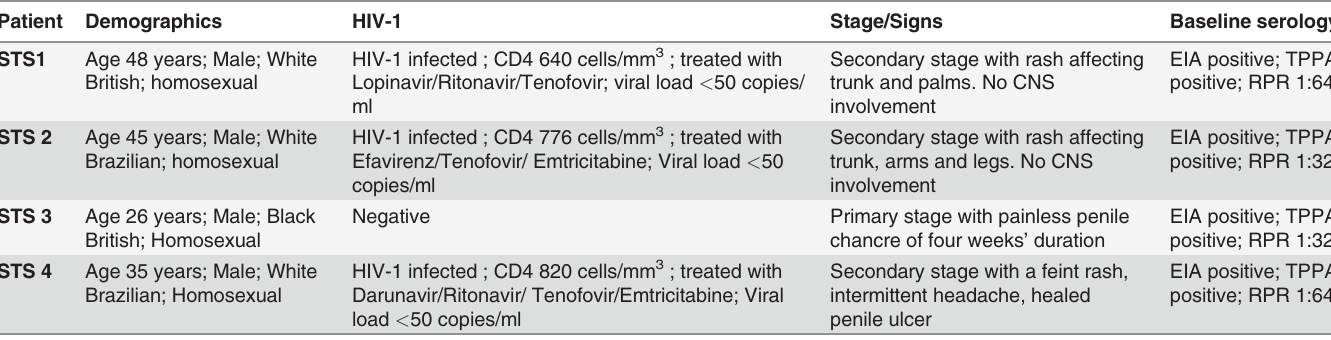
Table 1. Patient information: Baseline characteristics and